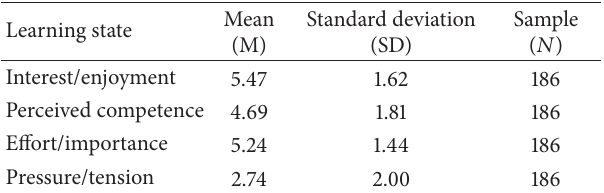
Table 1: Results of the